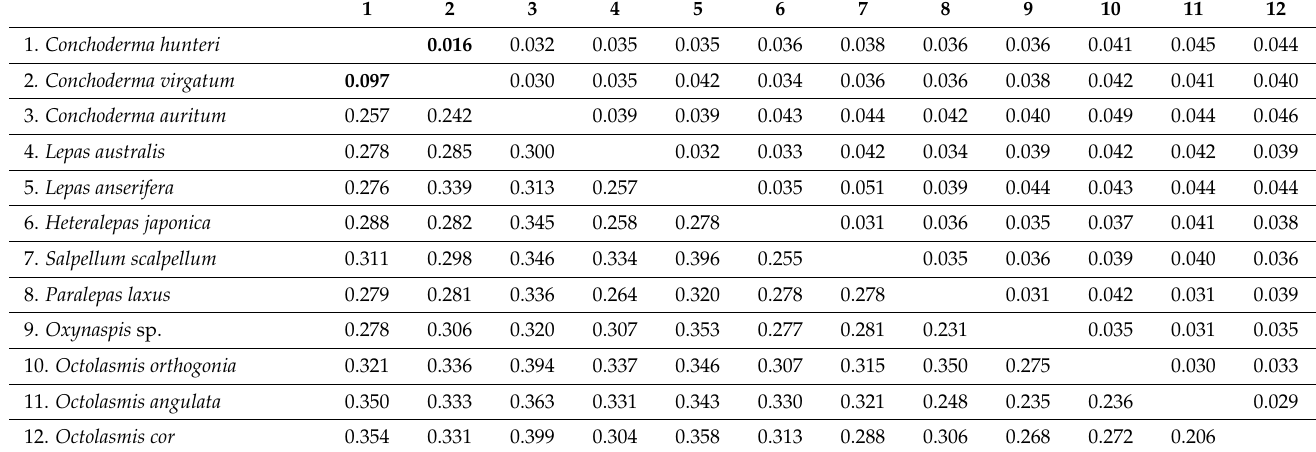
Table 2. Kimura 2-parameter (K2P) distances of COI sequences between species using MEGA X. The lower left of the matrix are the mean distances, and the upper right of the matrix are the SD. Bolded values indicate the comparison between C. hunteri and C. virgatum